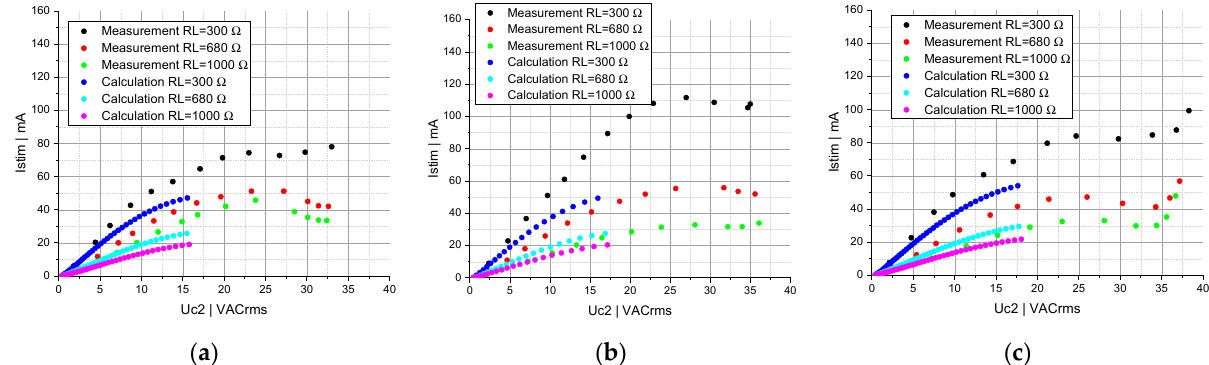
Figure 12. Stimulation current Istim as a function of the induced voltage Uc2 for a circuit topology of one nonlinear capacitor series-connected to two parallel-connected: ( a ) linear capacitors; ( b ) linear and nonlinear capacitors; ( c ) nonlinear capacitors. The measurements (black, red, green) and calculations (blue, cyan, magenta) were performed for R L = 300 Ω , 680 Ω and 1000 Ω , respectively.